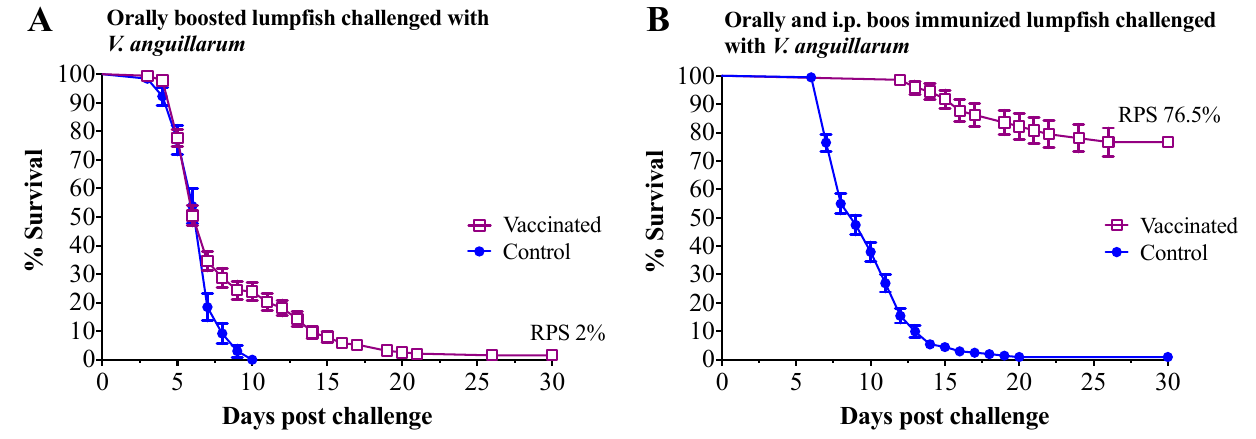
Figure 7. Cumulative survival rate of orally and i.p. immunized lumpfish after i.p. challenge with V. anguillarum (7.8 × 10 5 CFU dose − 1 ). ( A ) Survival (%) of orally immunized and orally boosted lumpfish after V. anguillarum challenge. Lumpfish were orally immunized as larvae and then orally boosted as juveniles. Control groups were mock-vaccinated using the same inoculation route. After 45 weeks post-initial immunization, the animals were then i.p. challenged; each treatment consisted of two tanks (see Figure 1). ( B ) Survival of orally immunized and i.p. boosted lumpfish. Lumpfish were orally immunized as larvae and then orally boosted as juveniles (see Figure 1). Control groups were mock-vaccinated using the same inoculation route. After 45 weeks post-initial immunization, the animals were then i.p. challenged; Each treatment consisted of two tanks (see Figure 1). Survival was assessed for 30 days. RPS: relative percentage survival; p < 0.0001.